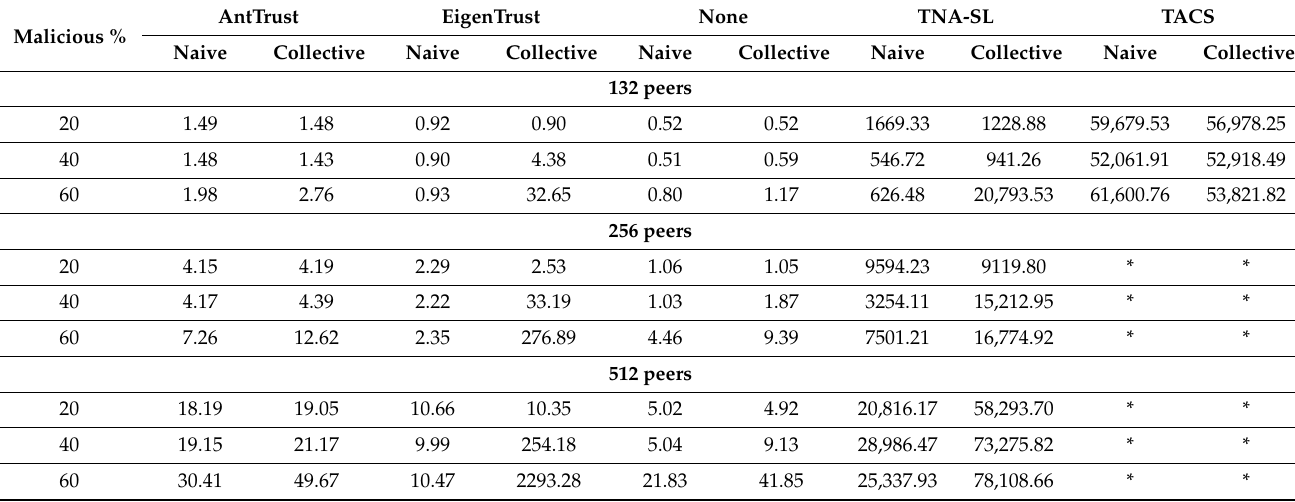
Table 4. Running time for 2500 transactions.